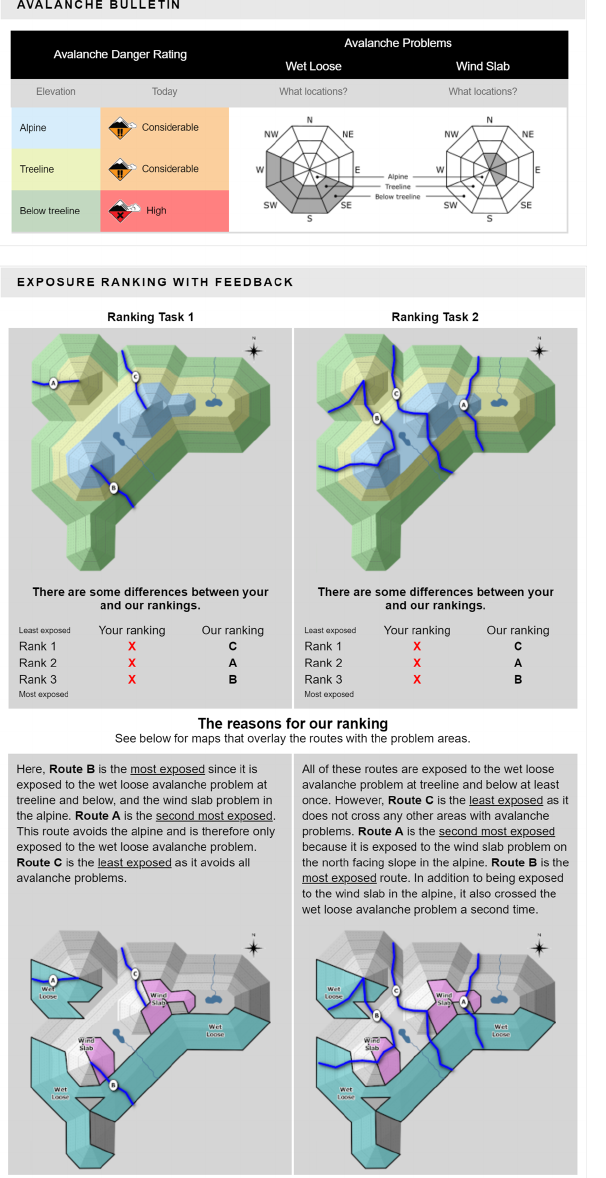
Figure A5. Screenshot of scenario 5 (ID 8) with avalanche bulletin information, route options, ranking solutions, and